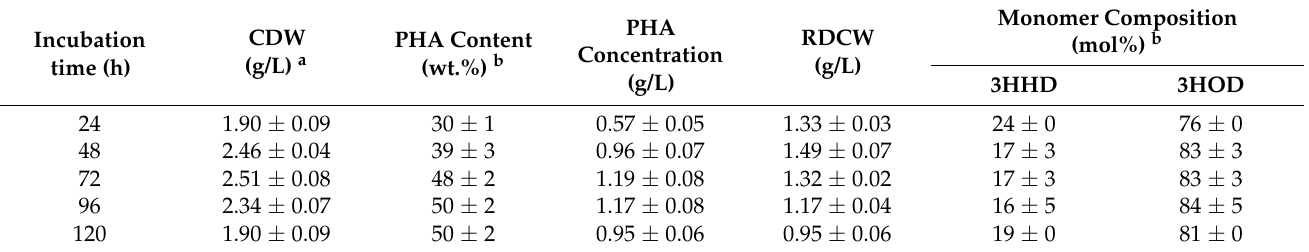
Table 3. Effect of incubation time on the growth and PHA biosynthesis by Acinetobacter sp. strain AAAID-1.5.